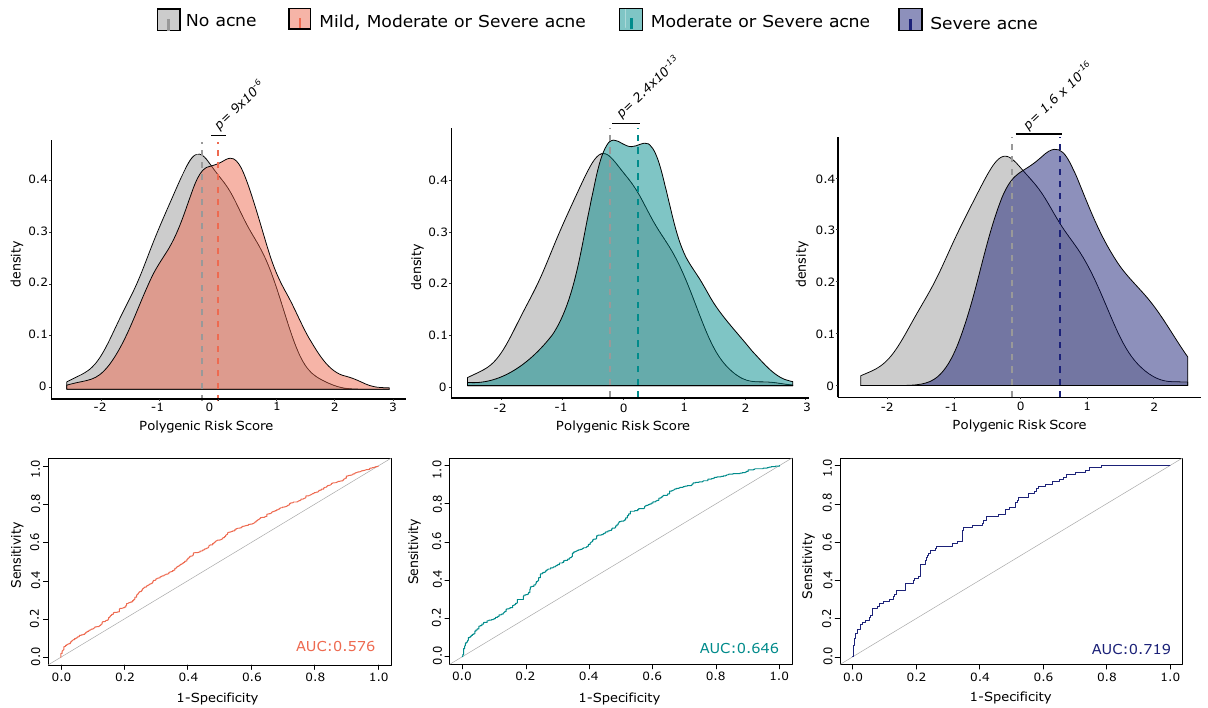
Fig. 3 Acne PRS analysis and prediction. Top panels show the difference in distributions of mean acne PRSs between individuals that report no acne (grey) to those that report having mild, moderate or severe acne (orange), those that report only moderate or severe acne (green) or those that report only having severe acne (purple). P -values were calculated using a two-sided Student ’ s t -test. Bottom panels depict the corresponding increase in predictive ability of the acne PRS in these different case groups using receiver operating characteristic (ROC) curves. AUC Area under the